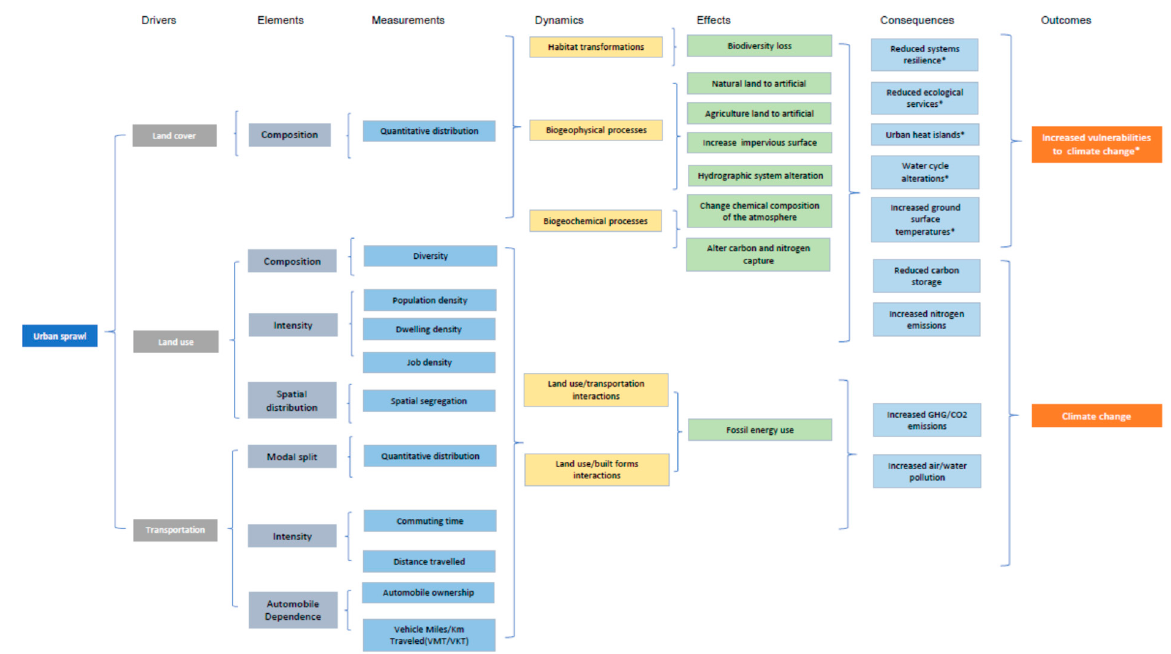
Figure 1. Conceptual diagram of the relationship between urban sprawl and climate change.